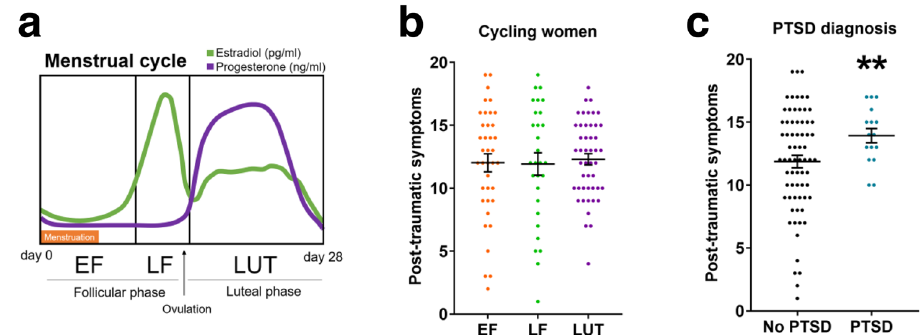
Fig. 6 Post-traumatic symptoms and menstrual cycle phases. a Menstrual cycle and related hormonal levels in women. b Post-traumatic symptom scores of women at 3 weeks post trauma analyzed by menstrual cycle phase at trauma (EF: n = 38, LF: n = 29, LUT: n = 47) c , or PTSD diagnosis within the fi rst year of follow-up (PTSD: n = 16, No PTSD: n = 69) ( P = 0.009). Data are expressed as mean ± SEM. ** P ≤ 0.01. In b , the main effect menstrual cycle was analyzed in a one-way ANOVA. In c , post-traumatic symptoms were analyzed using a two-tailed t test. EF early follicular, LF late follicular, LUT luteal phase, PTSD post-traumatic stress disorder. Source data are provided as a Source Data